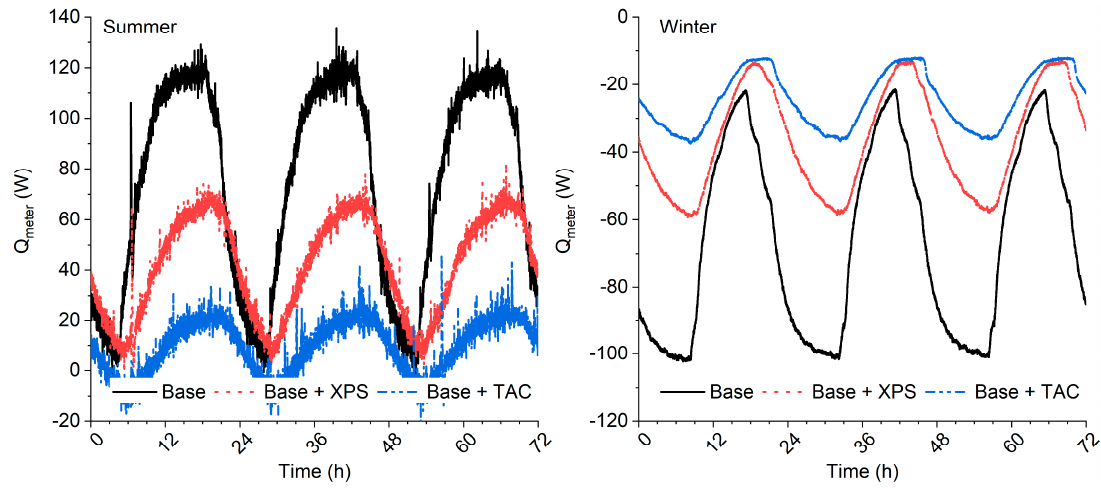
Figure 10. Measured heat gains to and heat losses from the meter chamber.